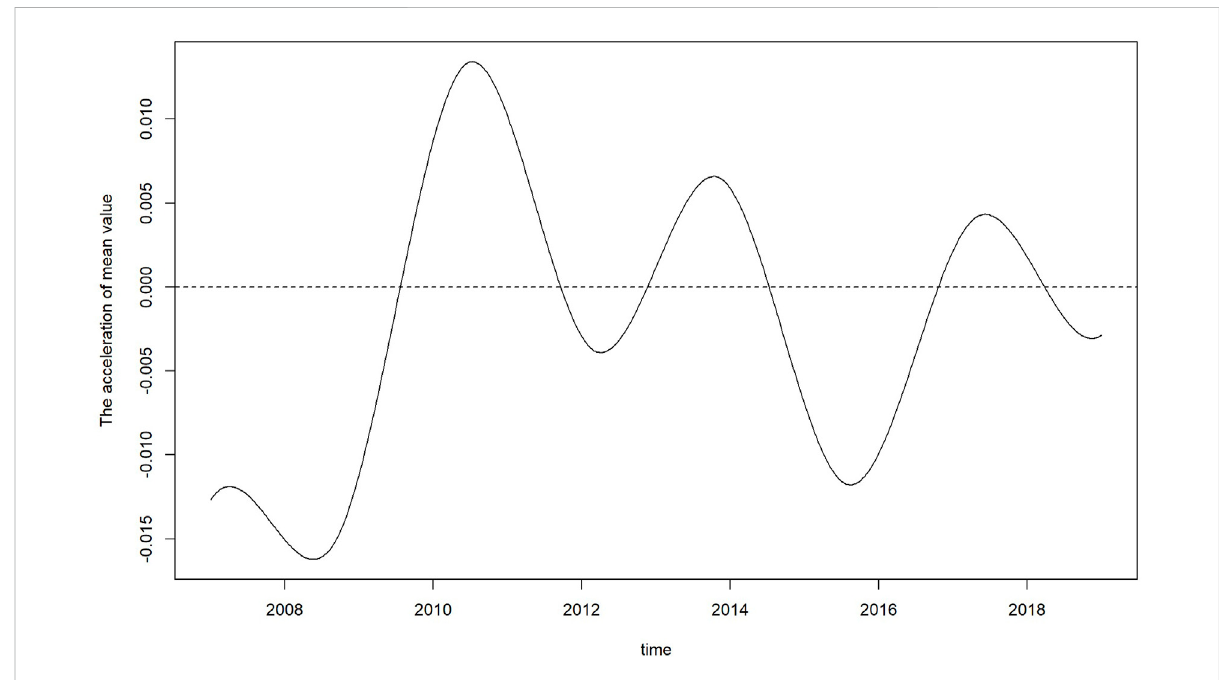
FIGURE 6 Acceleration curve of the re-electri fi cation index mean